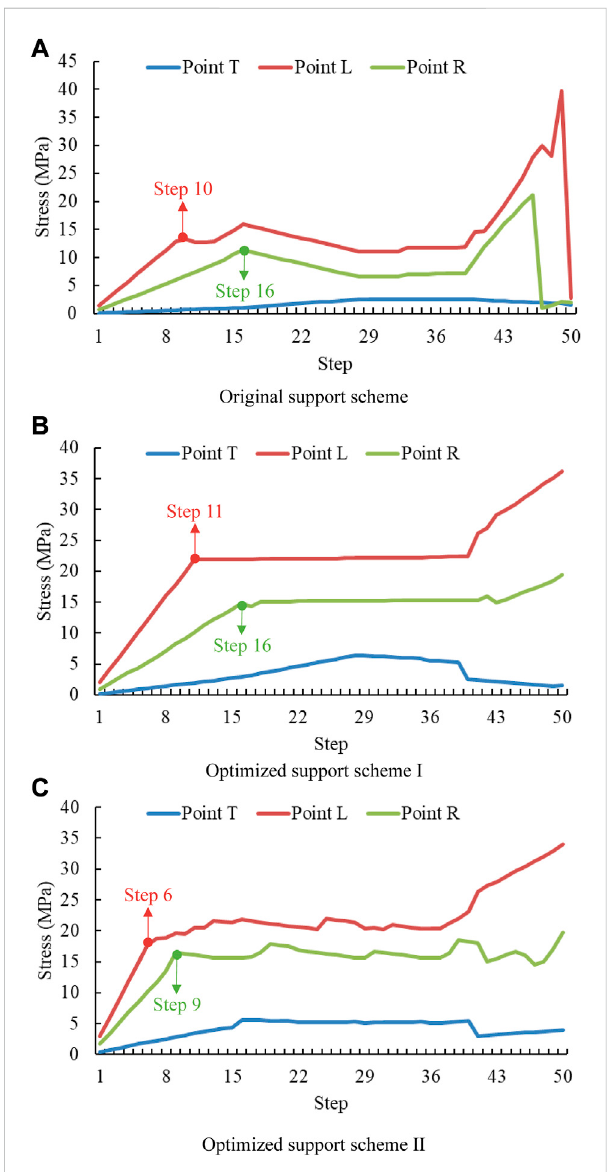
FIGURE 13 Variation trend of surrounding rock deformation under